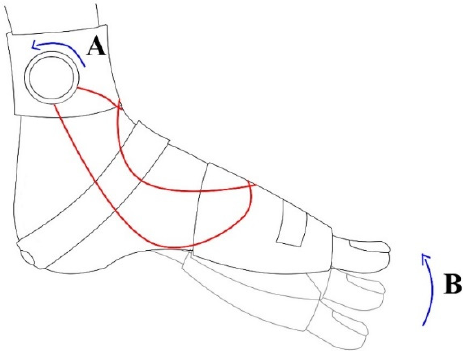
Figure 3. Lateral view of induction of passive ankle dorsiflexion. A: wire adjustor; B: passive ankle dorsiflexion.